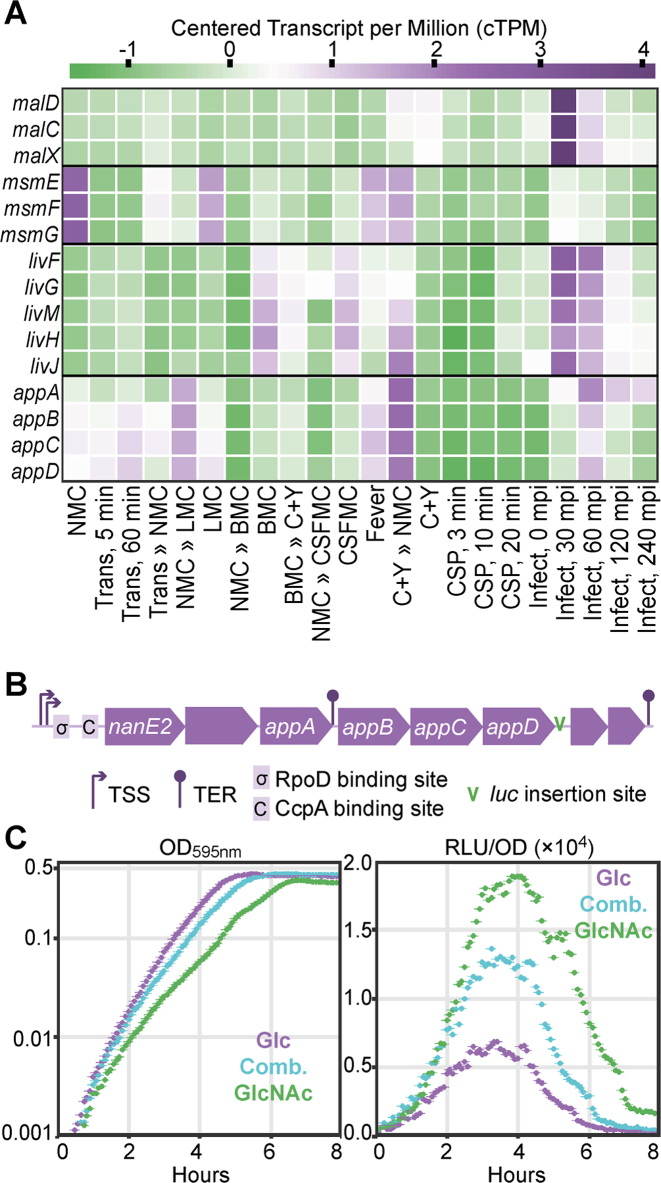
Condition-specific gene expression. (A) ABC transporters are strongly over-represented among condition-specific genes. The expression of malXCD, which encodes the maltose/maltodextrin transporter, peaks in Infection, 30 mpi, while msmEFG, which encodes a multi-sugar transporter, is highly expressed in NMC and to a lesser degree in LMC, C+Y » NMC and FEVER. Infection conditions (30 and 60 mpi) incite the expression of livFGMHJ, which encodes the BCAA transporter, and the transfer between C+Y to NMC (C+Y » NMC) activates the expression of appABCD, encoding an oligopeptide transporter. Purple indicates high expression and green indicates low expression, as indicated by the legend above the graph. (B) The upstream region of appABCD contains the RpoD- and CcpA-binding sites. luc is transcriptionally fused after appD. (C) While growth is barely affected by different carbon sources, the luciferin signal increases in the presence of N-acetylglucosamine. Glc: glucose; Comb.: equimolar combination of glucose and N-acetylglucosamine; GlcNAc: N-acetylglucosamine.